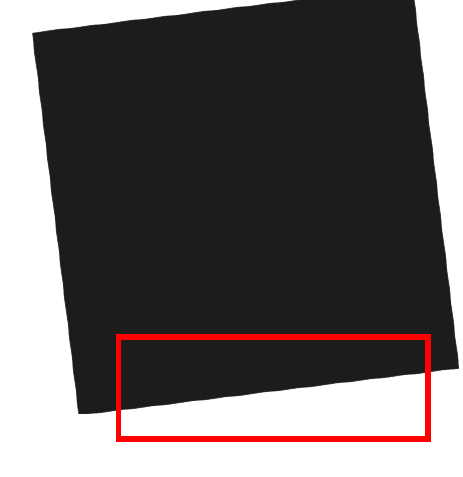
Figure5. ISO 12233 Test Pattern (ISO-12233:2014) The ISO12233 Test Pattern consists of the already familiar wedges from the EIA1965 test and bar groups from the USAF1951 target. The board also includes a number of diagonal elements which form the Slanted Edges. A Slanted Edge Test usually takes on the form of a black square (or one of its edges) on a white background that is rotated relative to the vertical by a few degrees as seen in Figure 6.